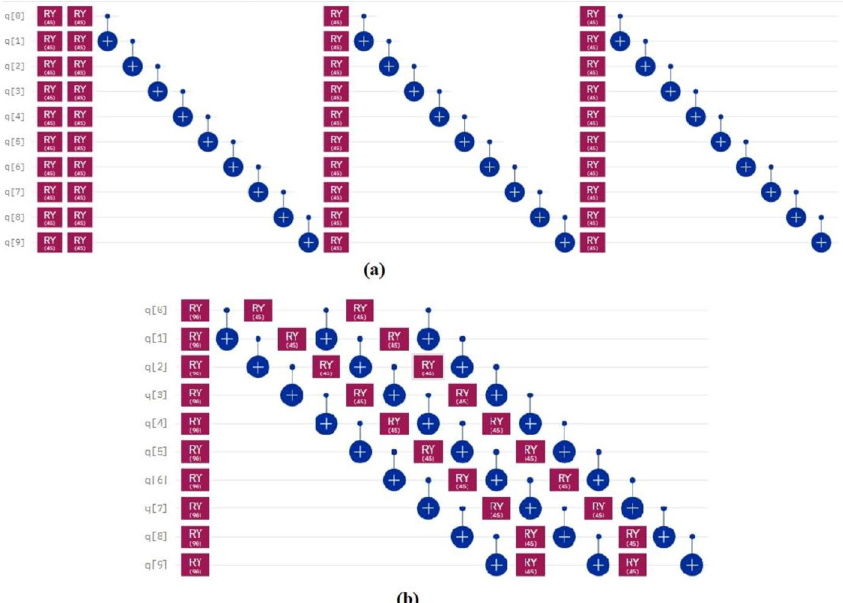
Figure 11. Demonstration of original 30 , and ( b ) improved quantum neural network circuits used for cancer diagnosis. The non-optimal circuit ( a ) is executed in 17 time steps, but the improved circuit, which has a reduction of 14.9% in the number of gates, its time step is reduced to 16.